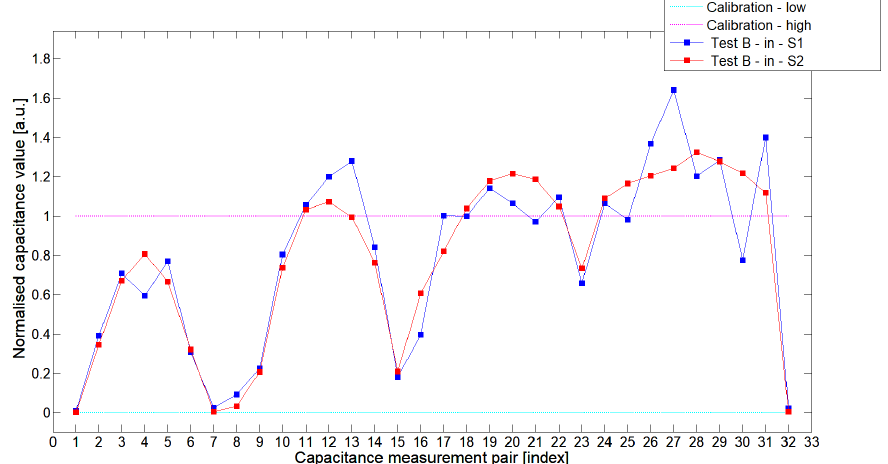
Figure 10. The 1st electrode measurement cycle (S1: 1->32 and S2: 1->32) for Test B in and S1—blue line, S2—red line. Cyan and magenta lines indicate calibration limits (0;1).